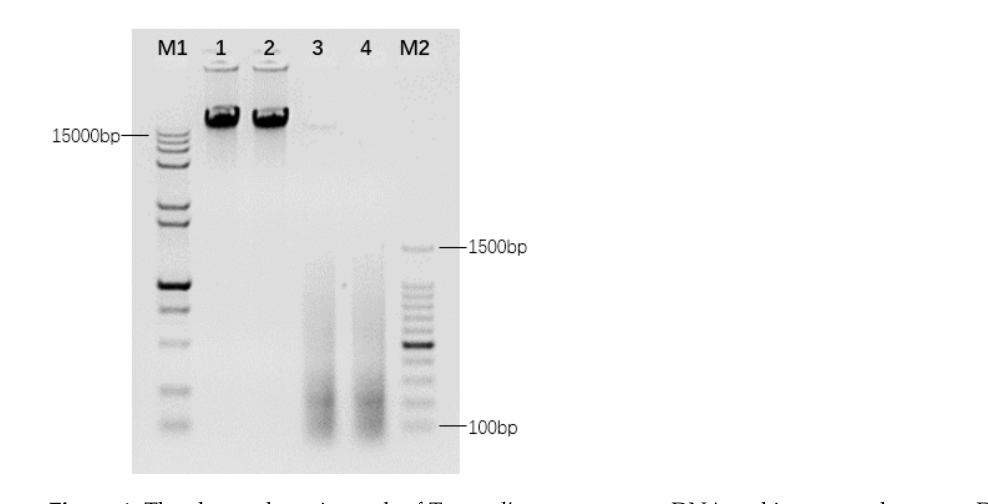
Figure 1. The electrophoresis result of T. arundinaceum genome DNA and interrupted genome DNA. M1: D15,000 + 2000 bp Marker; 1: Hainan 92–77 genome DNA; 2: Hainan 92–105 genome DNA; 3: The digested product of genome DNA from Hainan 92–77; 4: The digested product of genome DNA from Hainan 92–105; M2: 100 bp Marker.